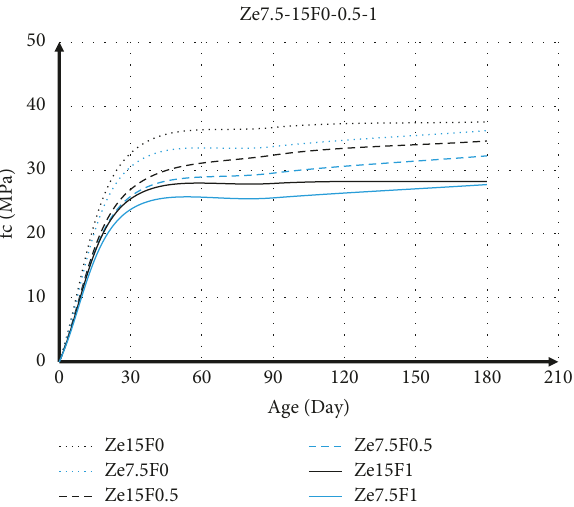
Figure 7: The compression of green concrete compressive strength containing zeolite with/without MPW